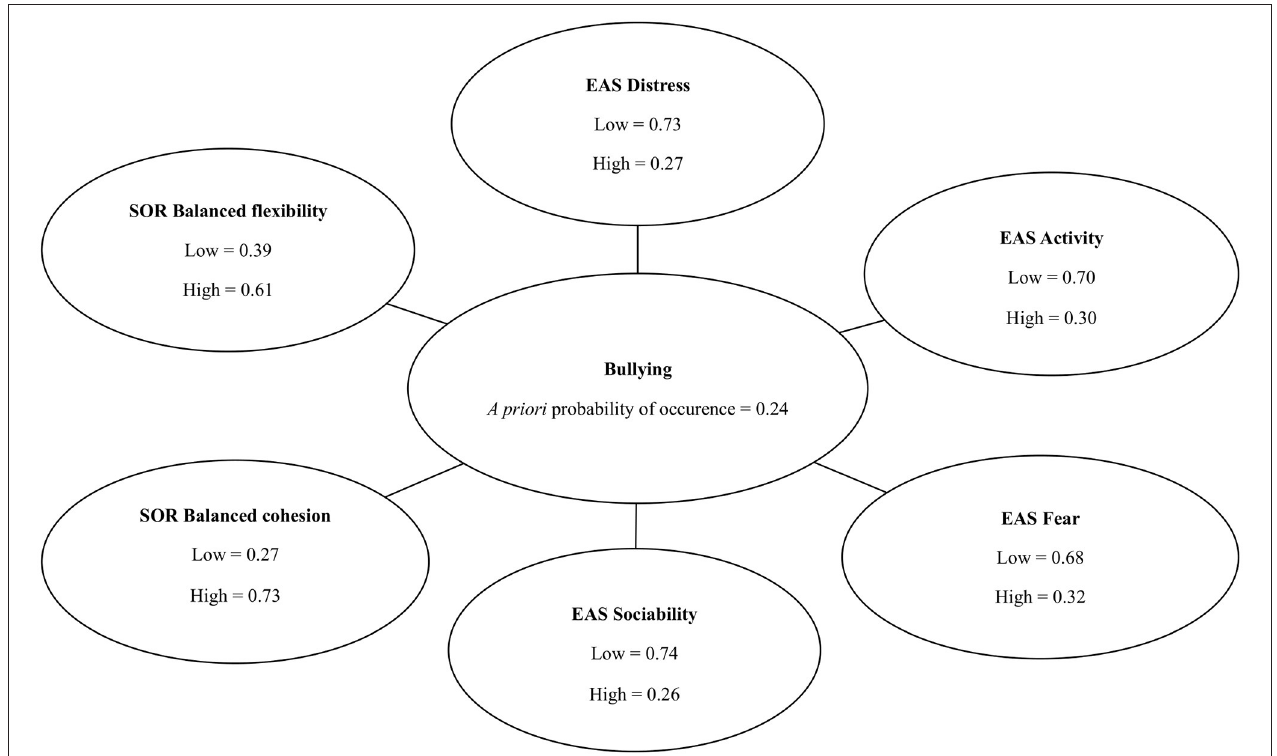
FIGURE 1 | A priori overall probability of bullying and distribution of values of the predictor